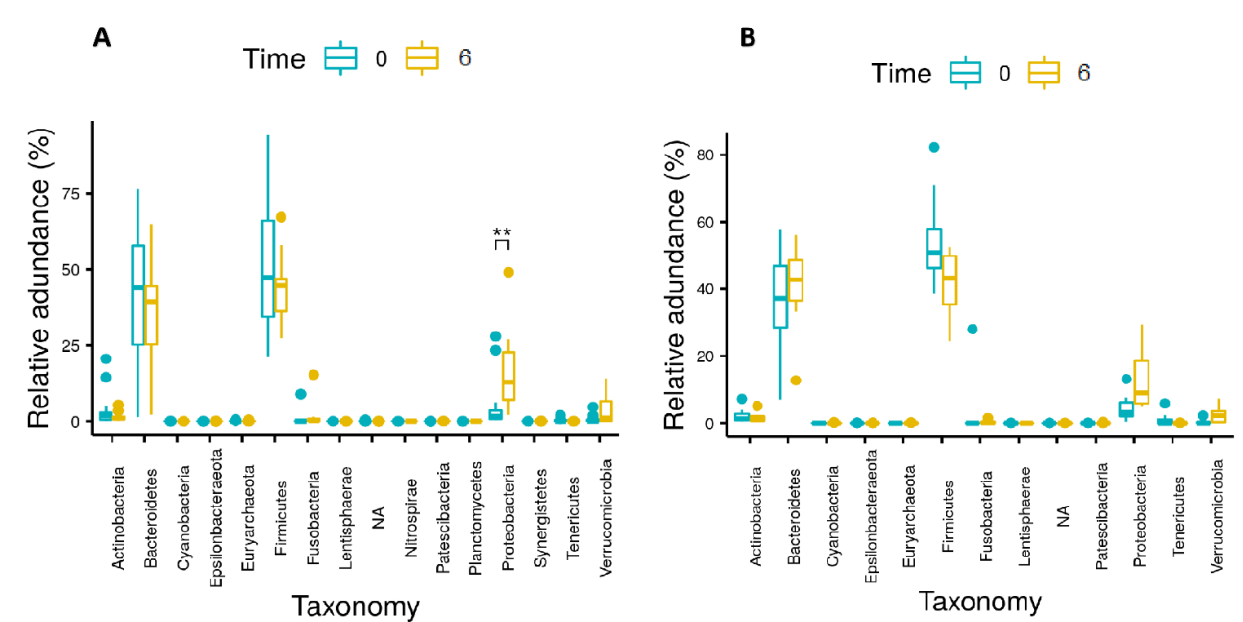
Figure 5. Changes in relative abundances of phyla for ( A ) patients ( n = 17) who did not develop SIBO and ( B ) patients ( n = 10) who developed SIBO from baseline (Time 0) to 6 months post-surgery (Time 6). Significant differences in abundance are marked with an asterisk (** indicates p < 0.005). NA = sequences that were assigned to the kingdom bacteria but were not assigned to a specific